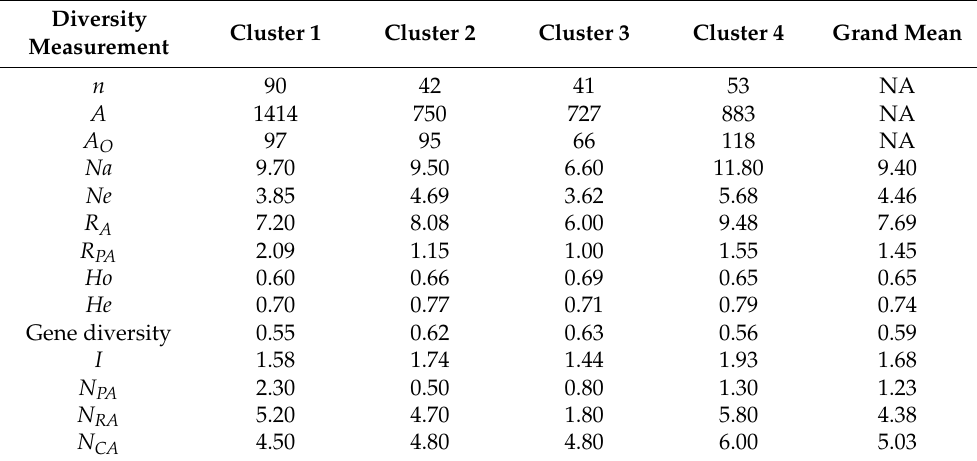
Table 4. Estimates of different genetic diversity parameters within the four genetic clusters.